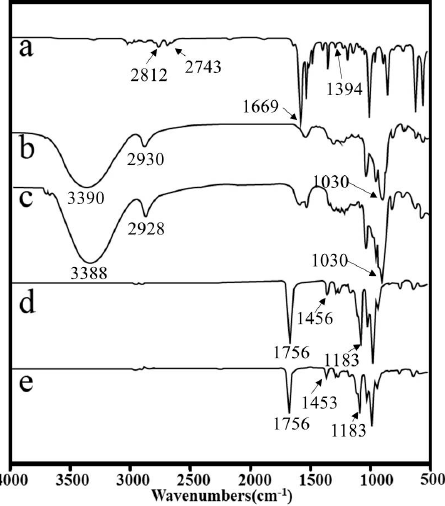
Figure 2. FT-IR spectra of ( a ) CA; ( b ) β -CD; ( c ) β -CD/CA; ( d ) pure PLA fibers; and ( e ) PLA/ β -CD/CA-1.5 fibers.